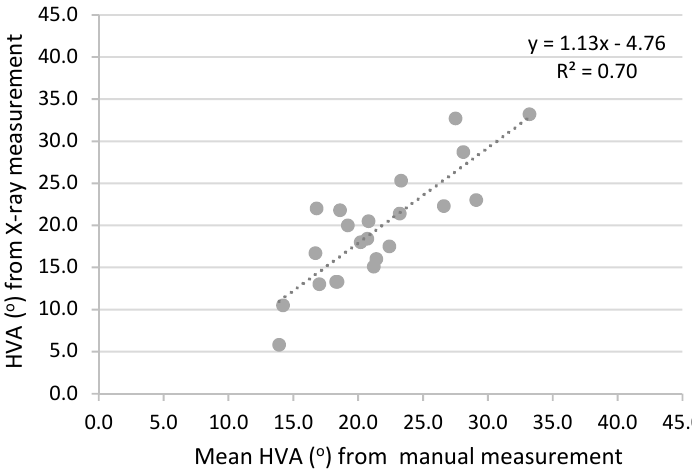
Figure 4. Regression between X-ray and manual measurements ( n = 22).